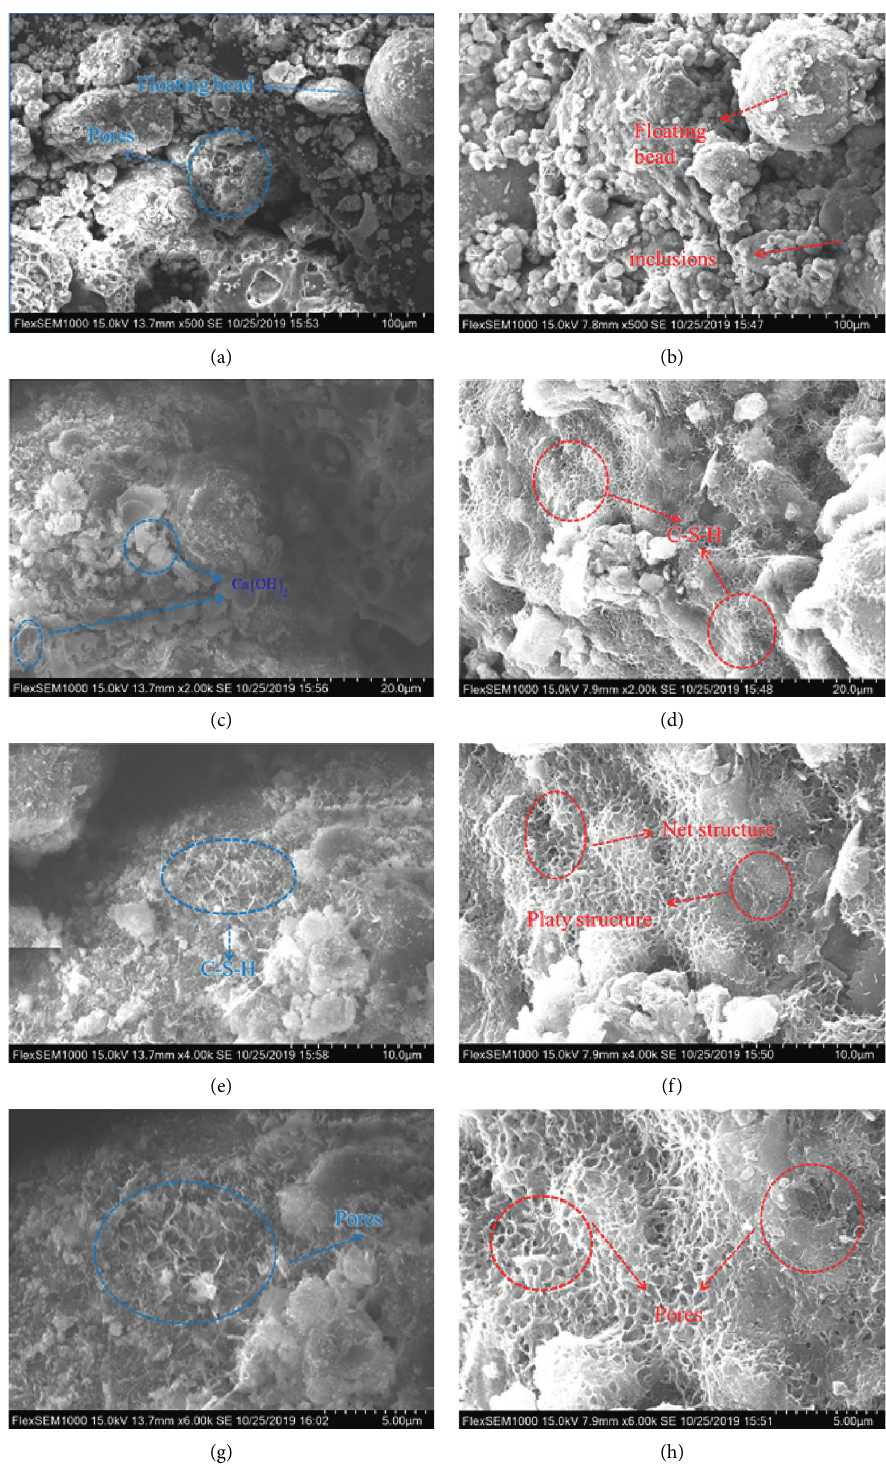
Figure 13: SEM observations of A and B. (a) A1 ( × 500). (b) B1 ( × 500). (c) A2 ( × 2000). (d) B2 ( × 2000). (e) A3 ( × 4000). (f) B3 ( × 4000). (g) A4 ( × 6000). (h) B4 ( ×